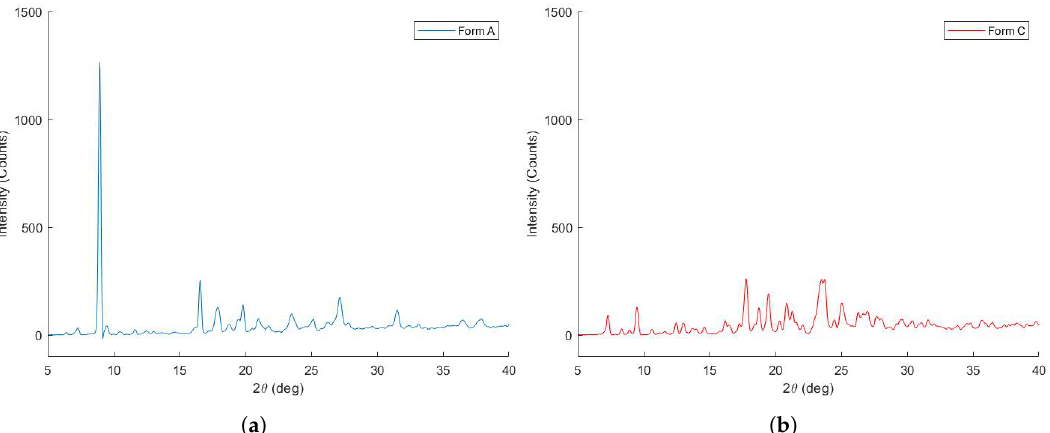
Figure 3. XRD profiles of zolpidem tartrate polymorphs before and after heat treatment, which were identified as zolpidem hemitartrate form A (hemihydrate) ( a ) and form C ( b ), respectively.